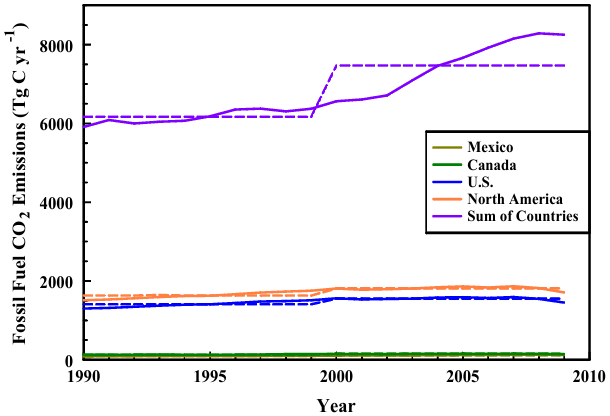
(Table 1 and Methods section) for each time period for 10 RECCAP-Trendy models. c With only two estimates there is no asymmetry in the distribution as evidenced by the equivalence of mean and median; likewise there is no mode.